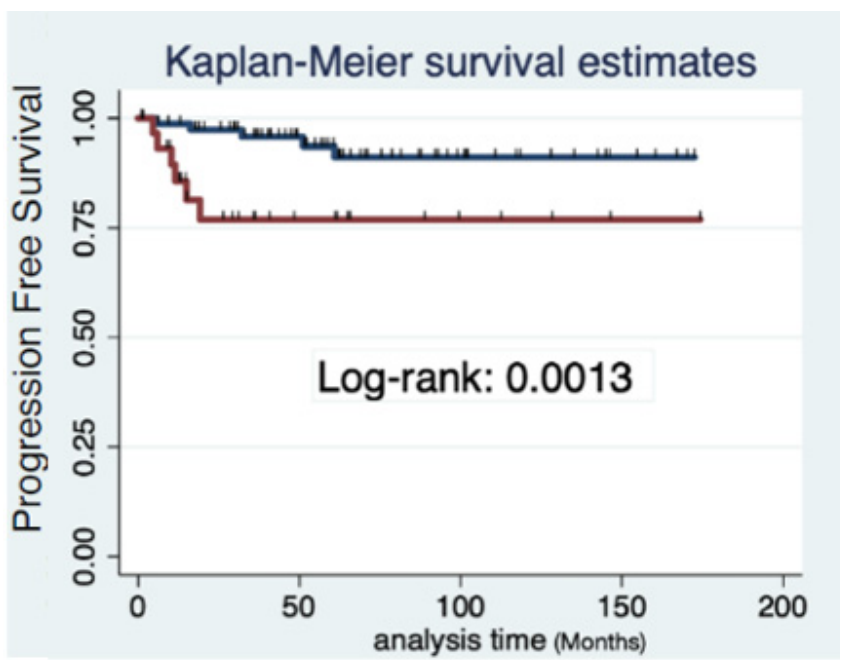
Figure 1. Progression-free survival in both groups. Kaplan–Meier estimates. log Rank: 0.011.